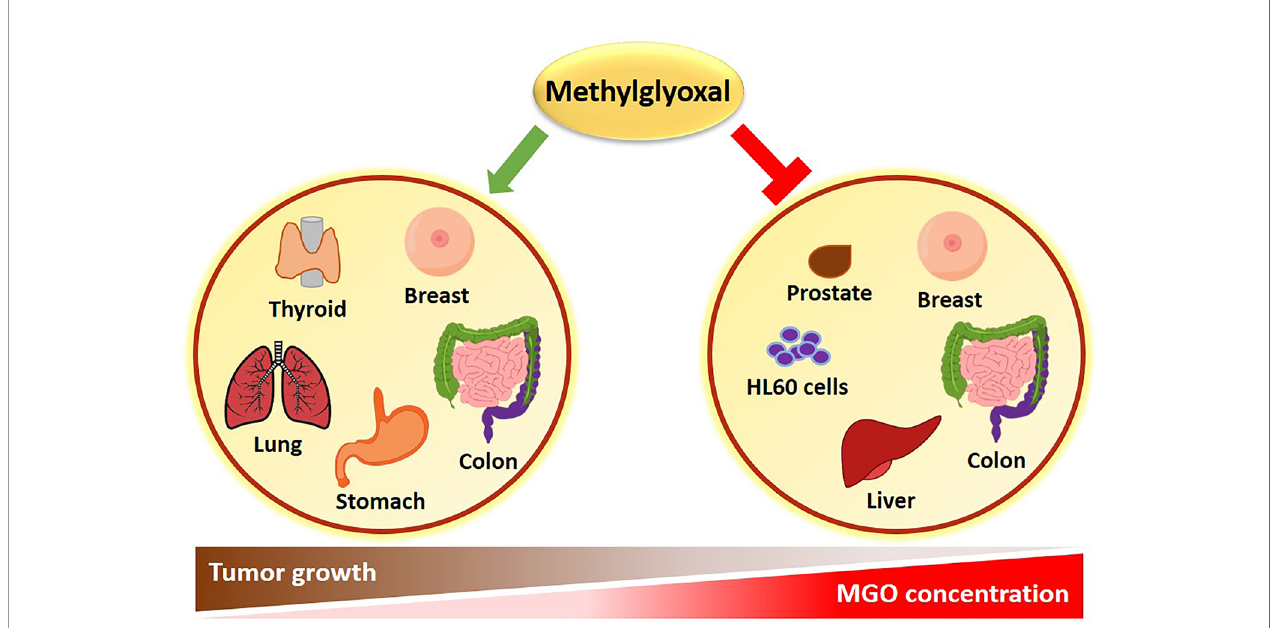
FIGURE 1 | Role of MGO in cancer. An inverse correlation exists between MGO concentrations and tumor progression. High MGO levels cause growth arrest in several types of cancer. Conversely, a lower increase in MGO concentrations can promote cancer